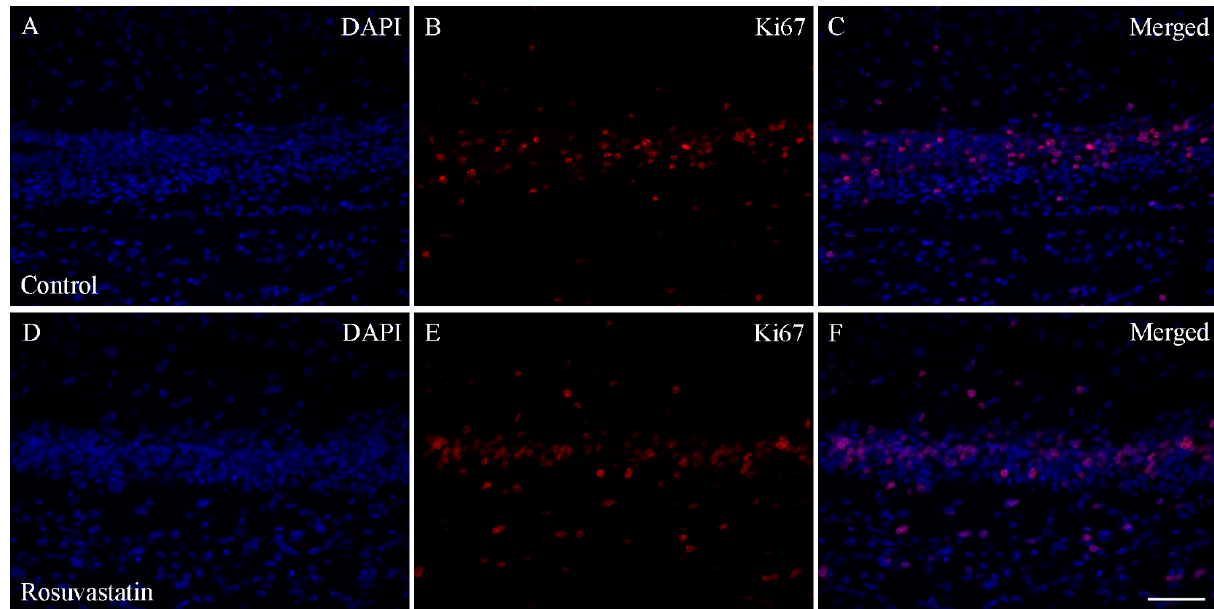
Figure 5. Ki67 immunohistochemistry of the hippocampus in control and prenatally RST-exposed newborn rats. The expression of the Ki67 protein in the tissue areas was quantified by the percentage of Ki67-positive nuclei (red) over the total number of nuclei (positive and negative nuclei). Immunohistochemical data analysis detected highly similar incidences for Ki67-immunopositive cells ( B , E ) among the DAPI dye-labeled cell nuclei (blue; A , D ) for both the controls (12.9%) and the prenatally RST-treated rats (12.5%). Merged pictures ( C , F ) are shown. Scale bar: 50 µm.